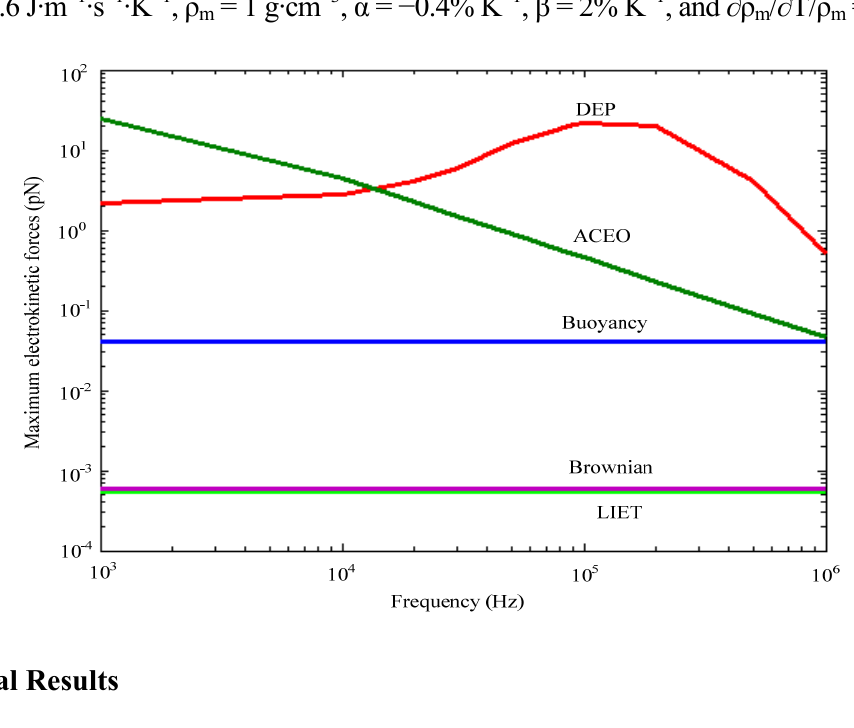
Figure 7. Electrokinetics analysis for a 10 μ m polystyrene bead, which shows that the DEP force dominates the micro-manipulation process when the applied frequency is higher than ~15 kHz. Here, we have assume deionized water is the liquid medium at room